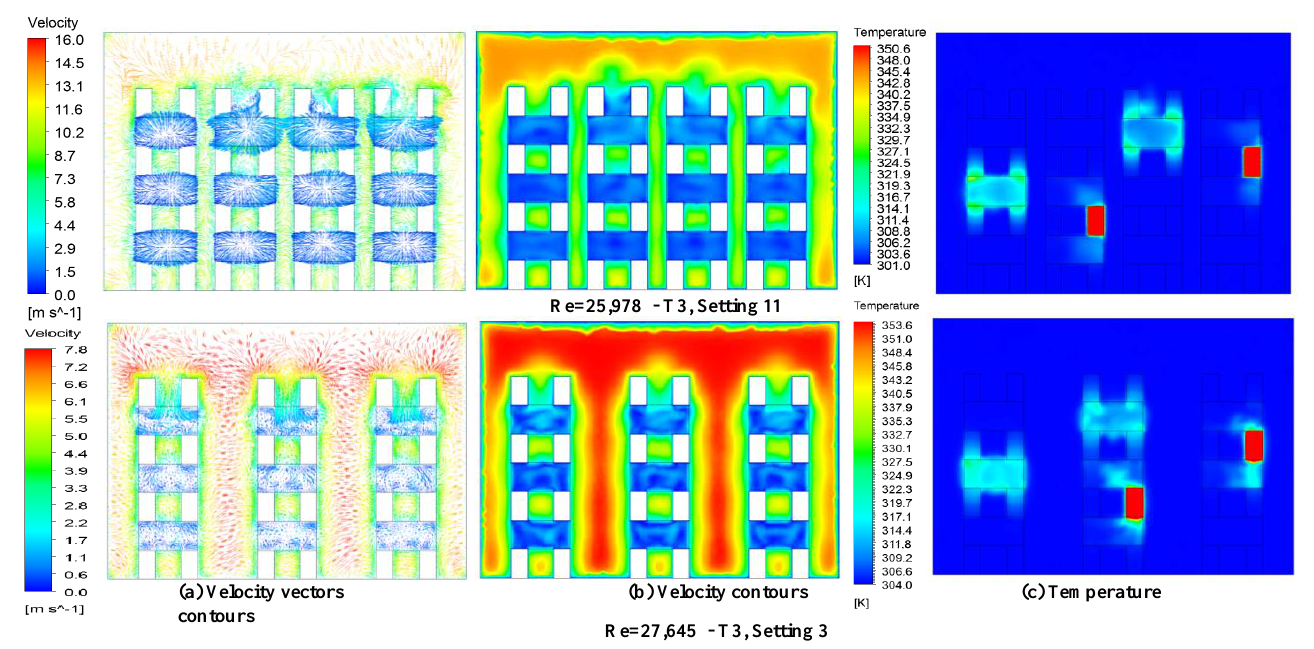
Figure 15. Velocity vectors and contours in a transversal channel between bricks in the fifth row.